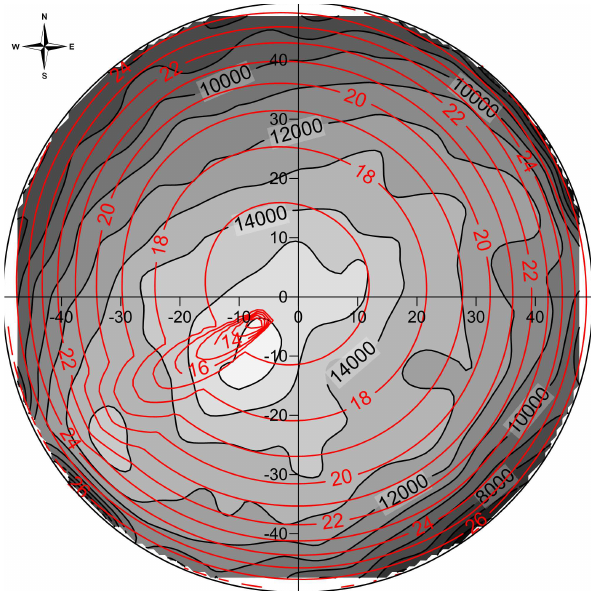
Fig. 7. Muon flux black contours in sr − 1 day − 1 units compared to the GPS-based direct measurements of the rock/soil thickness above the deployment point in the Aj´and´ek Cave (Barnaf¨oldi et al., 2012).